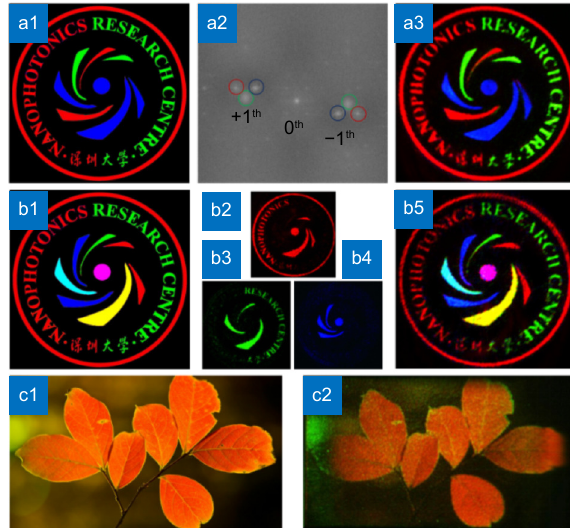
Fig. 5 | Color image display results realized using a red LD, a green LD and a blue LD, where the logo of our research center is again used as the target structure. ( a1 ) Structural design. ( a2 ) Three-color spectrum plane, where the three-color spectrum is sep- arated in space. ( a3 ) Measured three-color result image. ( b1 ) De- signed multi-color image. ( b2 ) Measured red pattern. ( b3 ) Measured green pattern. ( b4 ) Measured blue pattern. ( b5 ) Tri-color combina- tion pattern. ( c1 ) Actual loaded natural picture and ( c2 ) image dis- play picture.